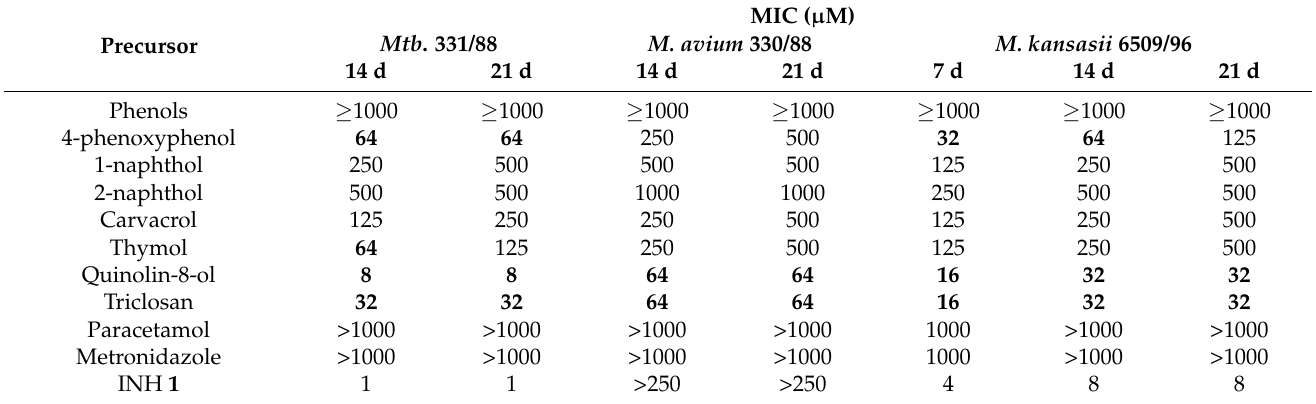
Table 2. Antimycobacterial activity of